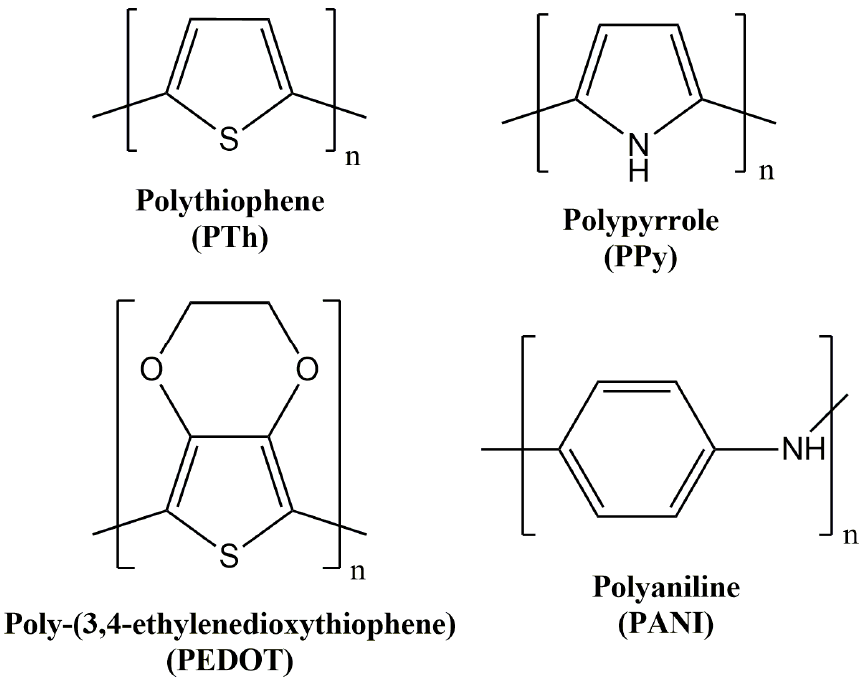
Figure 2. Chemical structure of the most relevant intrinsic conducting polymers.